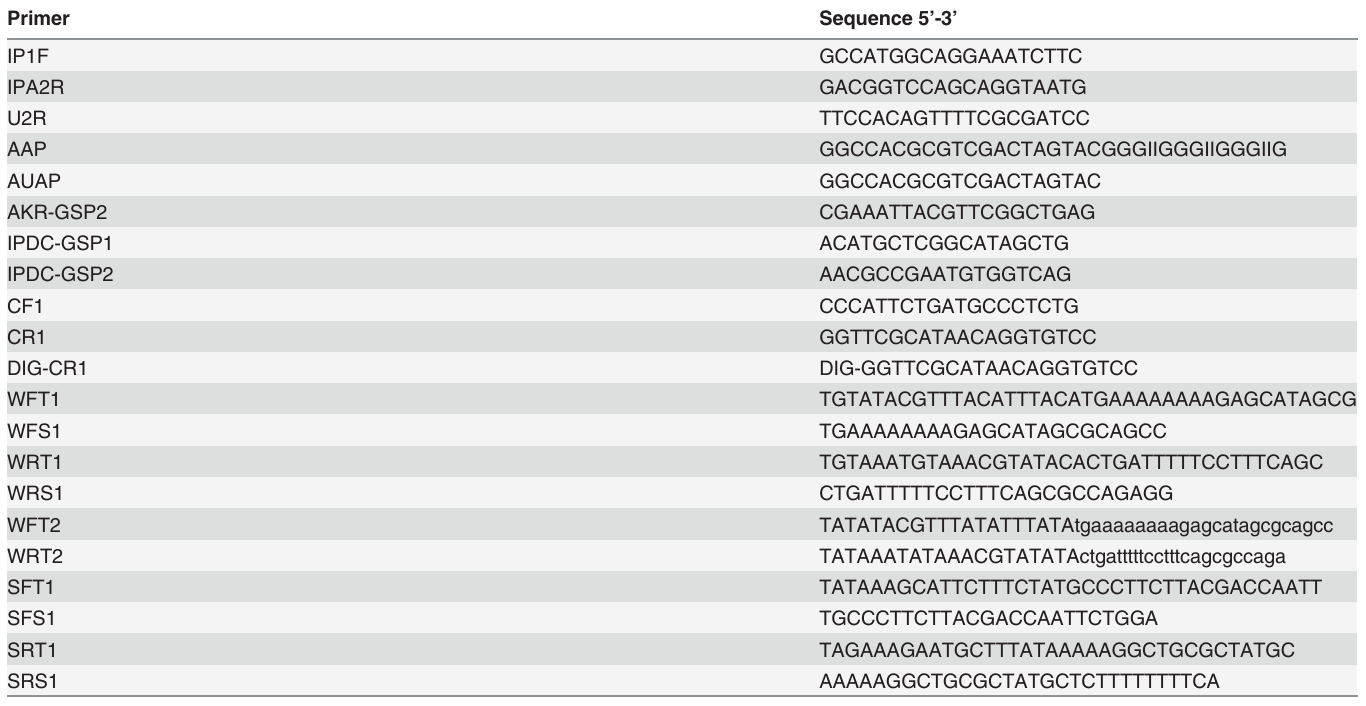
Table 2. PCR primers used in this